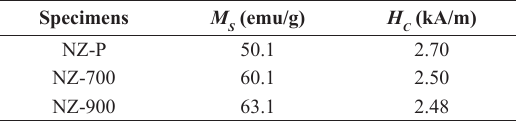
Table 2. The magnetic properties of different specimens.